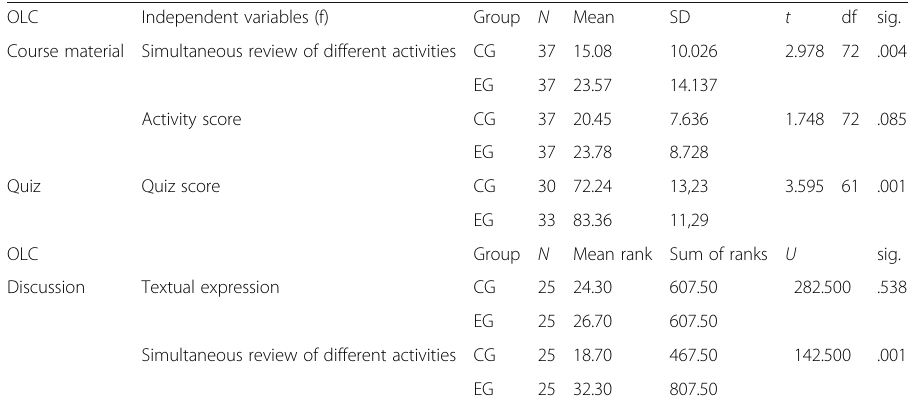
Table 7 Comparison of indicators of cognitive engagement scores OLC Independent variables (f)